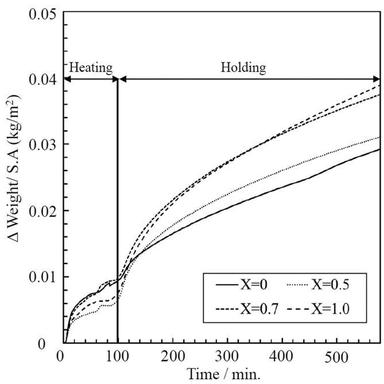
Weight change in TiCXN1-X-TiCrNbMoTa cylindrical samples during heating in the atmosphere measured via a thermogravimetry analysis.